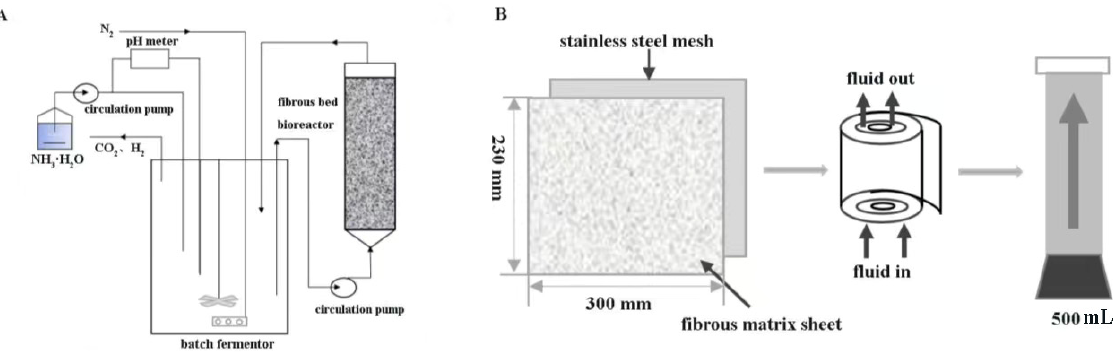
Figure 1. Bioreactor system in the process study. ( A ) shows schematic diagram of fibrous bed immobilization reactor; ( B ) shows schematic diagram of fibrous bed assembly.